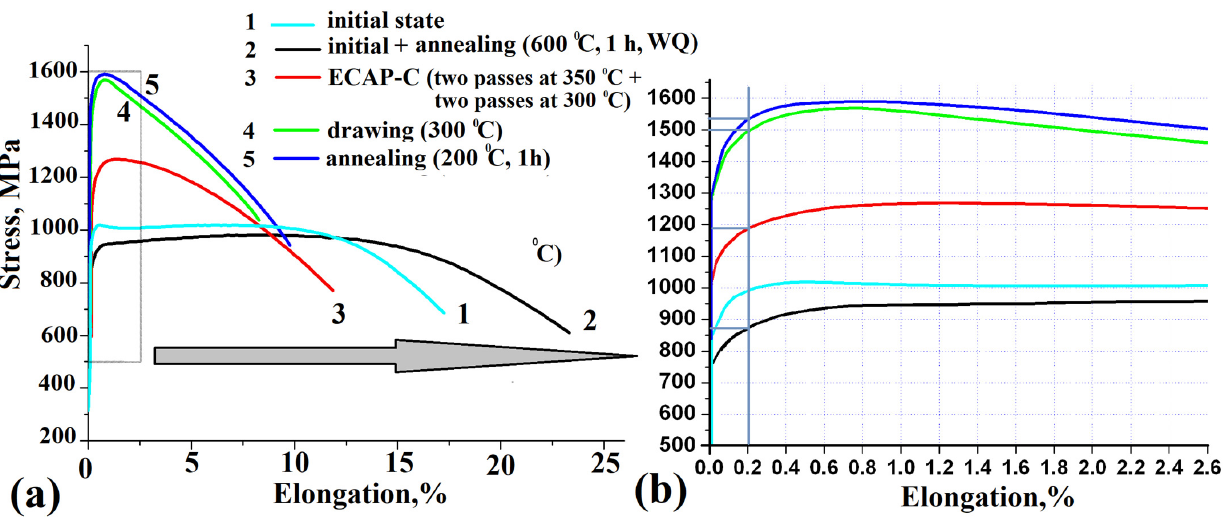
Figure 9. Results of the tensile mechanical tests for the Ti-15Mo alloy at each stage of the combined thermomechanical treatment: ( a ) typical engineering stress − strain curves; ( b ) an enlarged fragment of engineering stress − strain curves to an elongation of 2.6%.